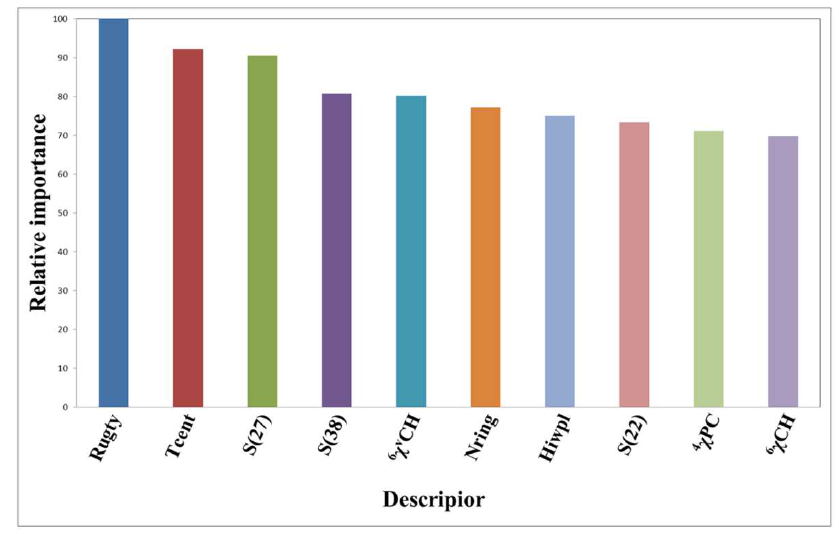
Figure 4. The relative importance of the 10 highest ranking descriptors in the optimal random forest (RF)